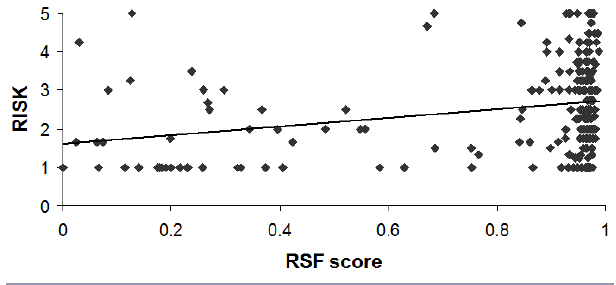
Fig. 4 . Relationship between the amount of risk survey respondents from Clearwater County, Alberta, associated with coexisting with cougars and the probability of cougar selection for habitat within a 500-m radius around the respondent’s home (resource selection function [RSF]